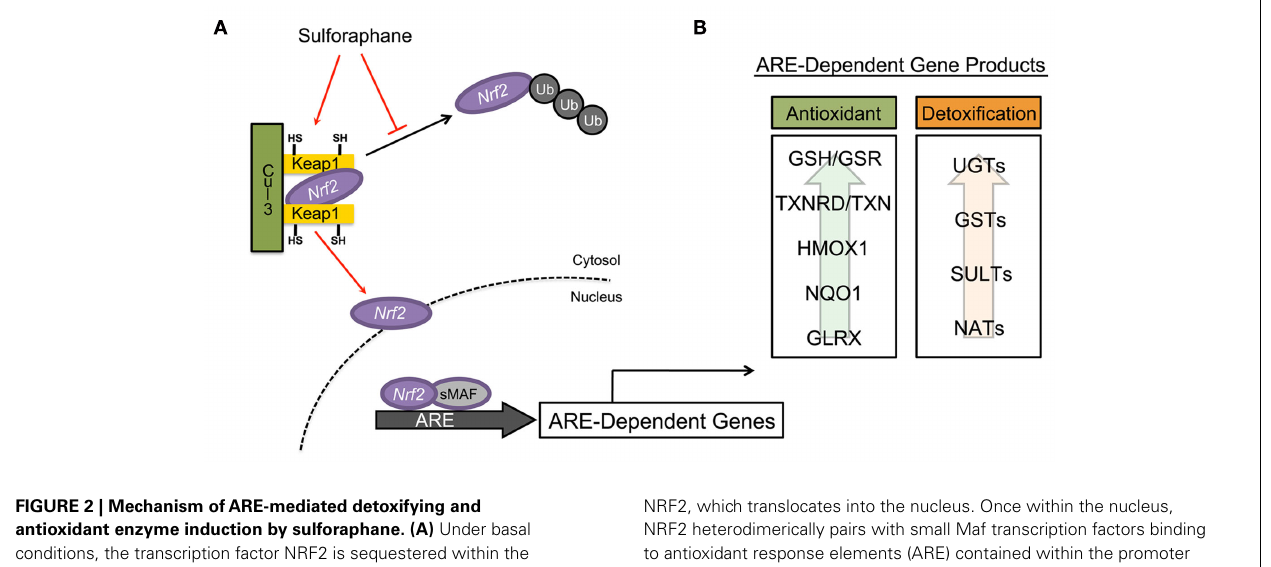
FIGURE 2 | Mechanism ofARE-mediated detoxifying and antioxidant enzyme induction by sulforaphane. (A) Under basal conditions, the transcription factor NRF2 is sequestered within the cytosol by the repressor proteins Keap1 and cullin 3 (CUL3), presenting it for proteosomal degradation via ubiquitination. Sulforaphane, through modification of the highly redox-sensitive cysteine residues of KEAP1, facilitates the dissociation of the KEAP1/CUL3/NRF2 complex, releasing